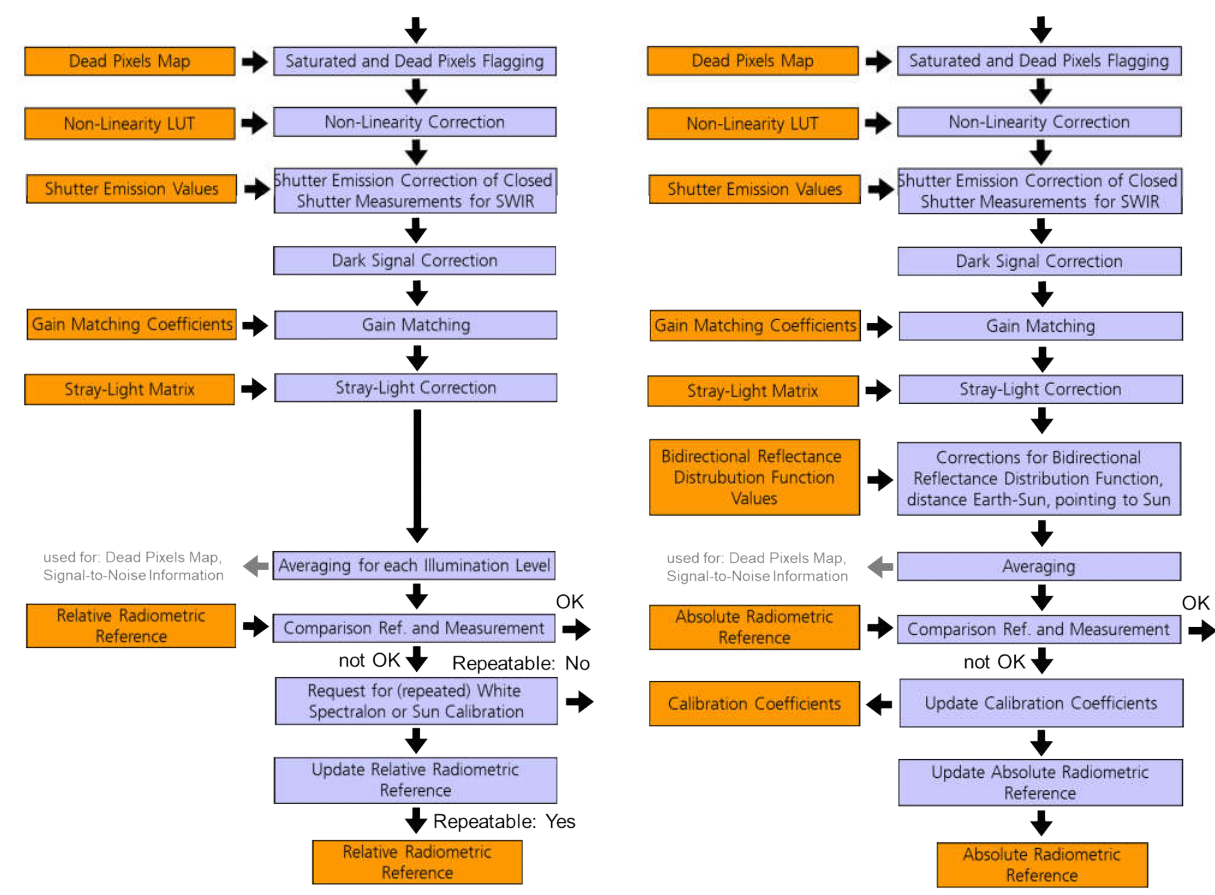
Figure 4. Corrections for relative radiometric calibrations. Figure 5. Corrections for absolute radiometric